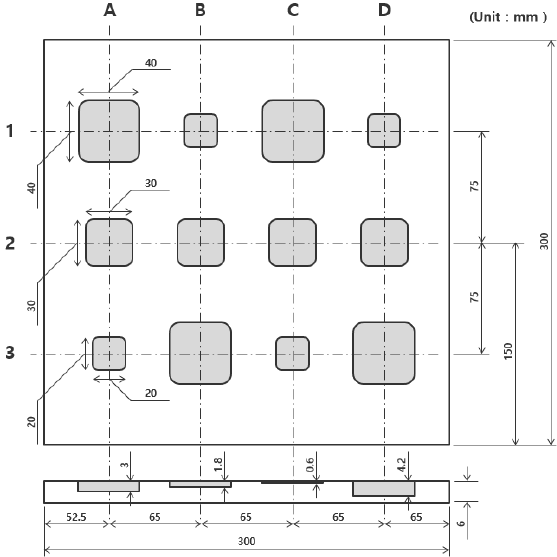
Figure 4. Dimensions of S275 specimen with various sizes of thinning defects.